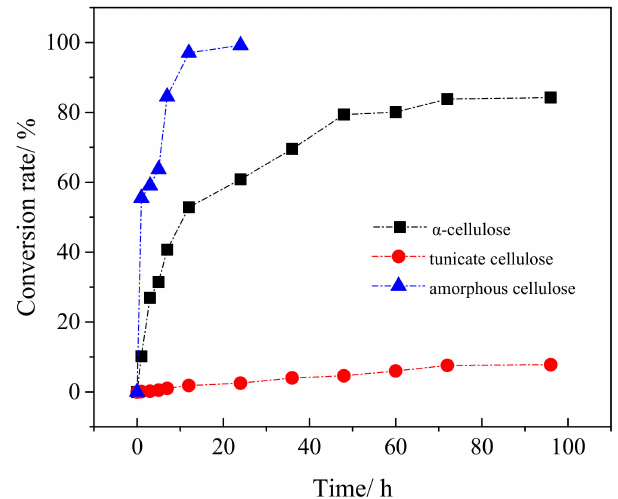
Figure 10. The cellulose conversion from various crystalline celluloses during enzymatic